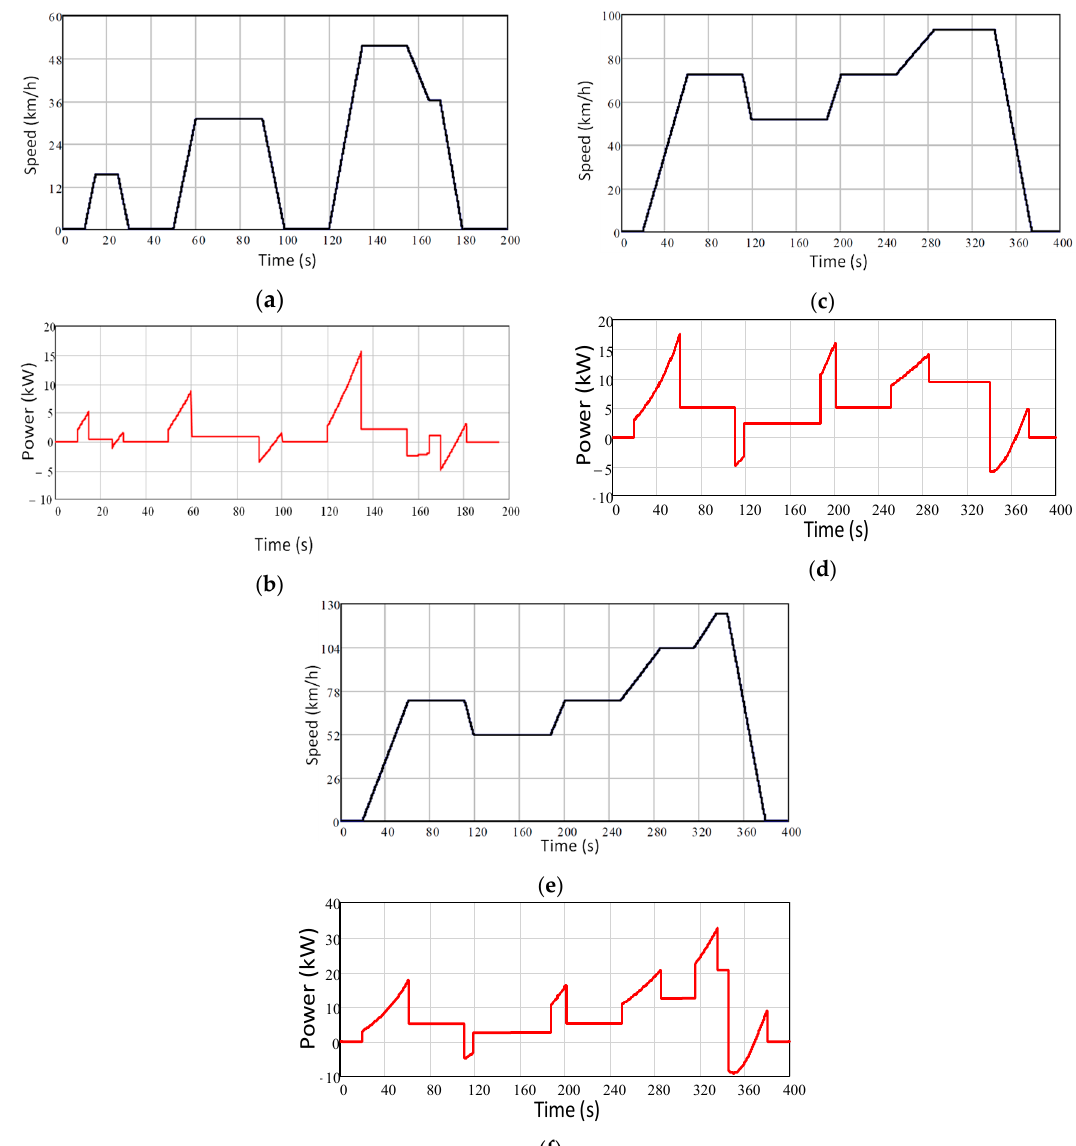
Figure 2. ( a ) ECE-15 driving profile. ( b ) Power demand under ECE-15 driving profile. ( c ) EUDCL driving profile. ( d ) Power demand under EUDCL driving profile. ( e ) EUDC driving profile. ( f ) Power demand under EUDC profile. Power demands have been obtained for a light vehicle [28].